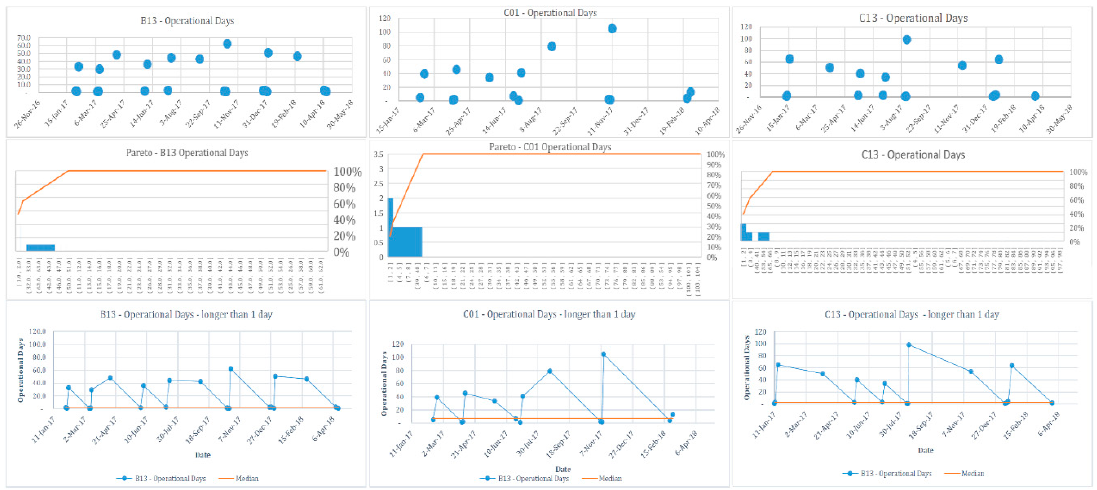
Figure 7. Operational day counter (first row), Pareto chart (second row), and Filtered Operational day counter (third row).